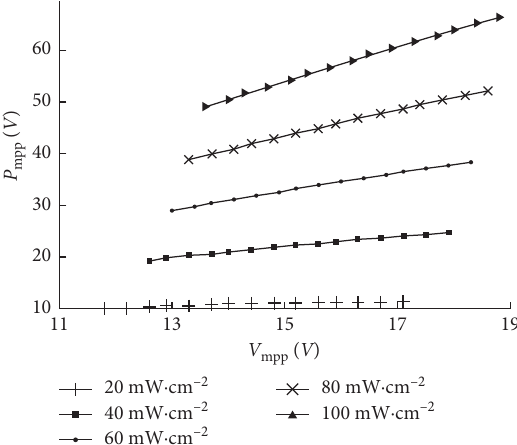
P mpp and mpp under different